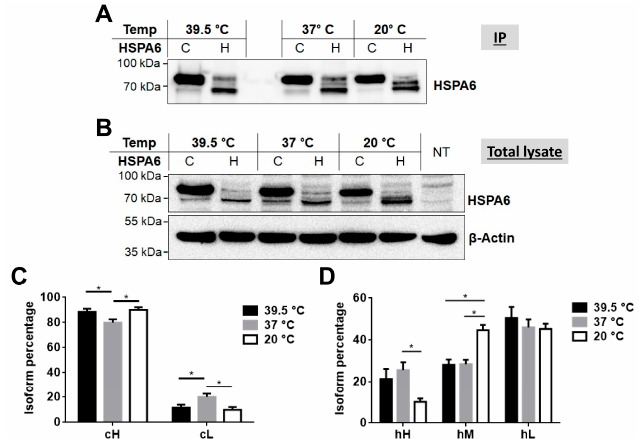
Figure 4. Variable response of camel and human HSPA6 isoforms to different temperatures. ( A ) Western blots of immunoprecipitated camel (C) or human (H) HSPA6 proteins from transfected COS-1 cells and exposure to different temperatures (39.5 °C, 37 °C and 20 °C); ( B ) The loading controls for (A) utilized equal amount of proteins in lysates of transfected COS-1 cells; ( C , D ) Quantification of each camel/human HSPA6 isoform in the total protein isoforms. Camel HSPA6 is identified by two isoforms (higher (cH) and lower (cL)) while human HSPA6 exhibits three isoforms (higher (hH), middle (hM) and lower (hL)). Statistically significant values are denoted by an asterisk and the blots are representative data sets out of five independent repeats.